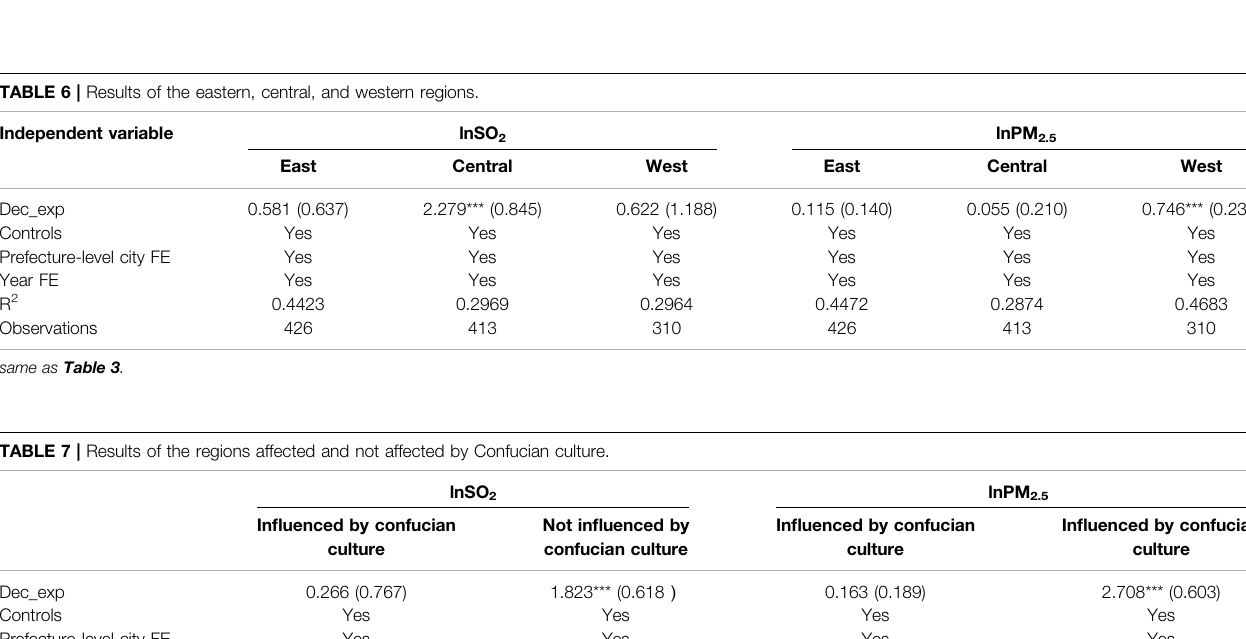
same as Table 3 .